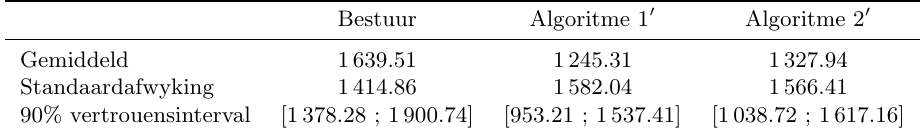
Tabel 2: Gemiddelde verliese (in rand) met D ( P i , t ) eksponensieel en α en β gelyk aan die